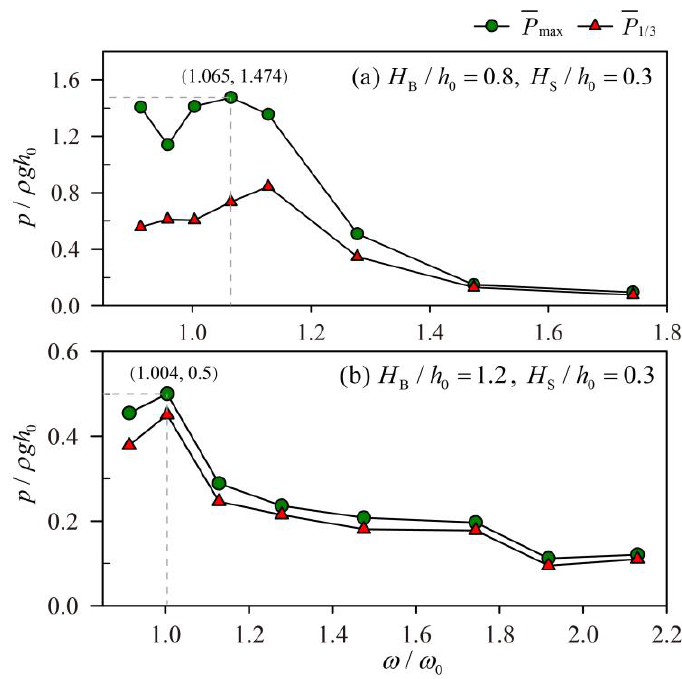
Figure 11. Variation trends of impact pressure with different gap sizes ( T = 1.91 s, ω / ω 0 = 1.004). ( a )